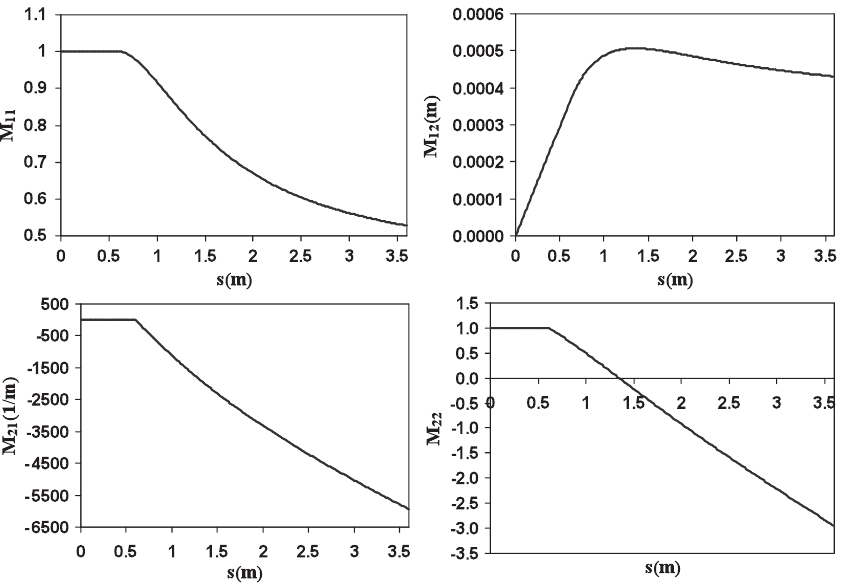
¼ 59 : 8 m (cid:1) 1 , (cid:3) ¼ 0 : 82 , c rf